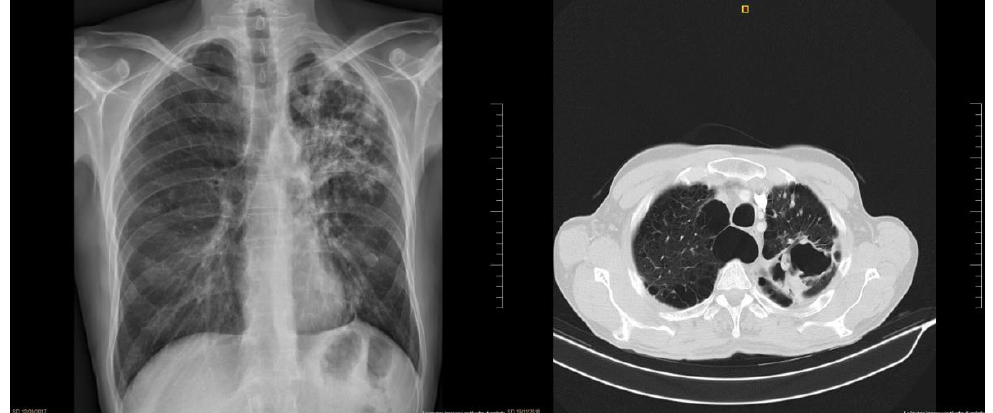
Figure 1. Lung images: (1) lung chest X-ray at diagnosis shows a left apical cavitation and surround- ing infiltrate; (2) lung chest CT scan after clinical impairment shows central emphysema, fibrosis in both upper lobes with significant loss of volume, apical left lobe and diffuse bronchiectasis and a large apical cavity in left lung of approximately 7.1 cm.